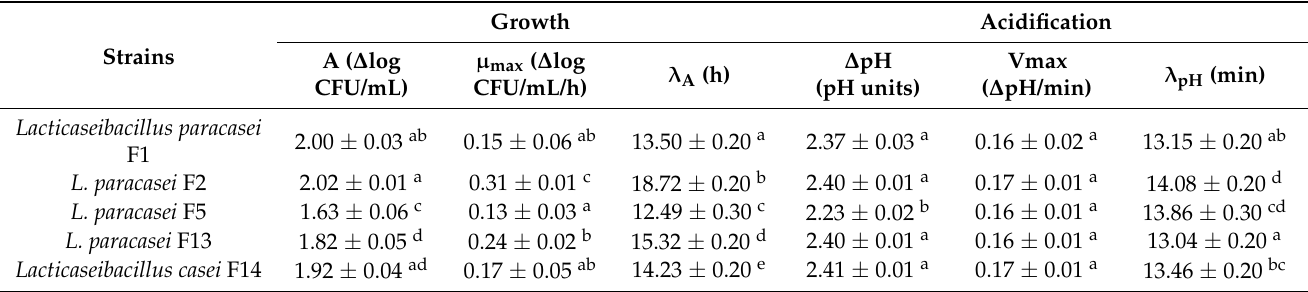
Table 3. Parameters of the kinetics of growth and acidification of representative bacterial strains during fermentation of whole UHT cow’s milk for 48 h at 40 ◦ C: increase of cell density (A), max- imum growth rate ( µ max ), length of the lag phase ( λ A ), pH decrease ( ∆ pH), rate of pH reduction (Vmax) and length of lag phase ( λ pH ). Each value was expressed as the mean of three analytical replicates ± standard deviations. One-way ANOVA and individual post hoc comparisons with the Tukey–Kramer was performed separately for each column: values with different superscript letters differ significantly ( p <